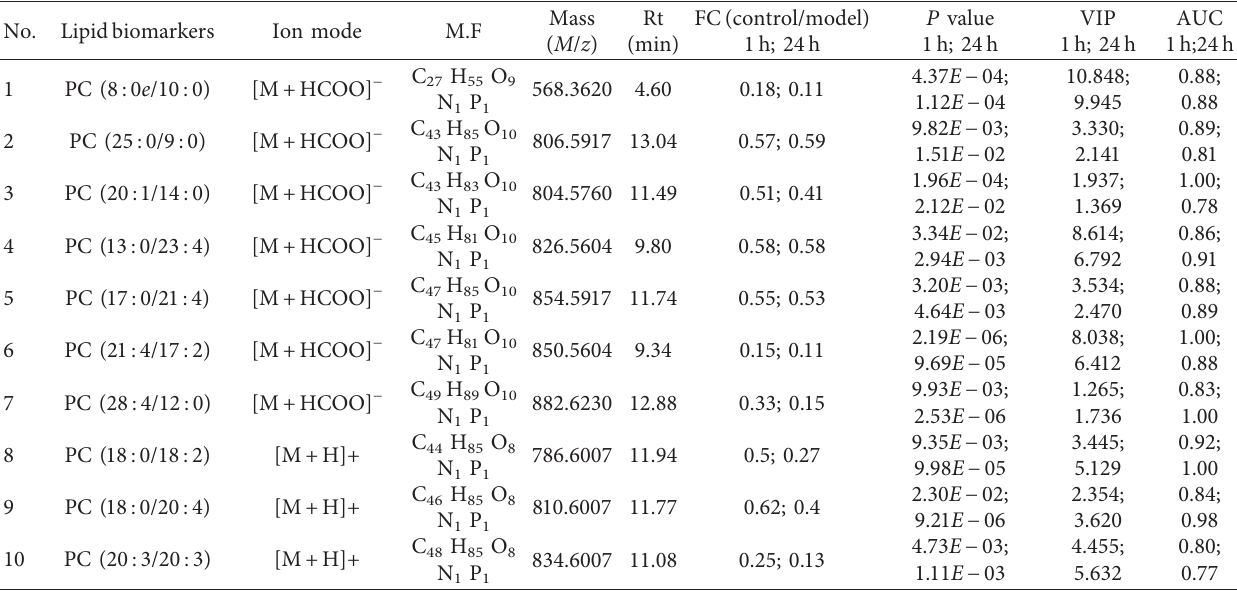
Table 2: Identification of important potential serum lipidomic biomarkers in migraine model